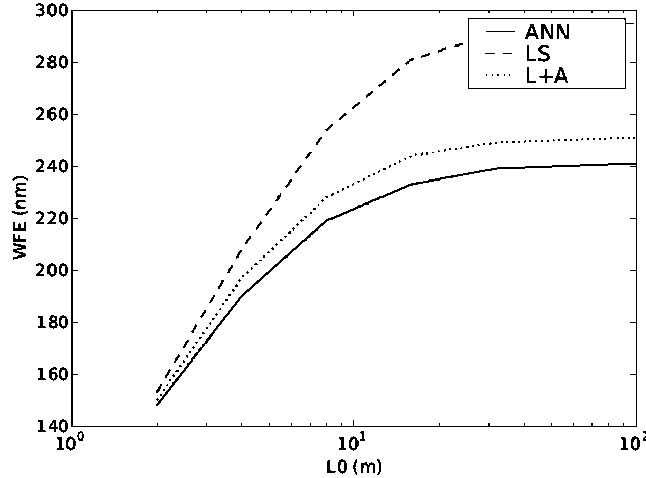
using Test 2 atmospheric 0